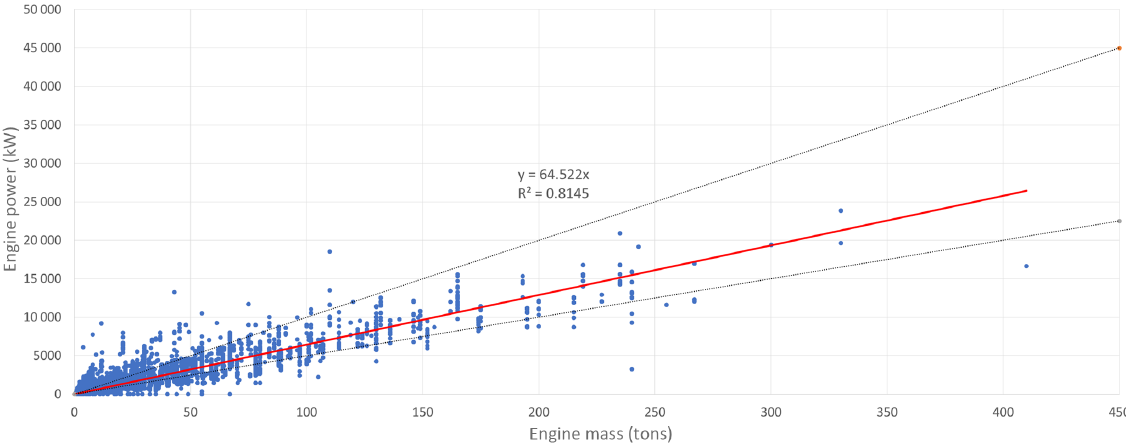
Figure 1. Predicted and actual main engine masses of 31500 four-stroke engines. The black lines represent the range given by Watson (1998). The red line indicates the mass/power dependency used in this study for cases where engine mass could not be